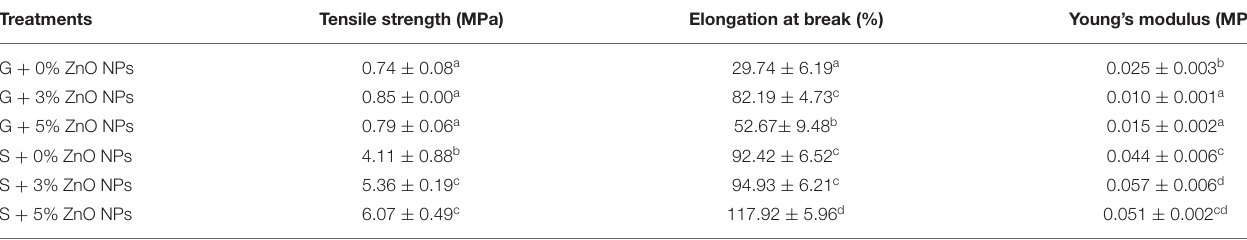
TABLE 1 | The tensile strength, elongation at break, and Young’s modulus of bionanocomposite films. Treatments